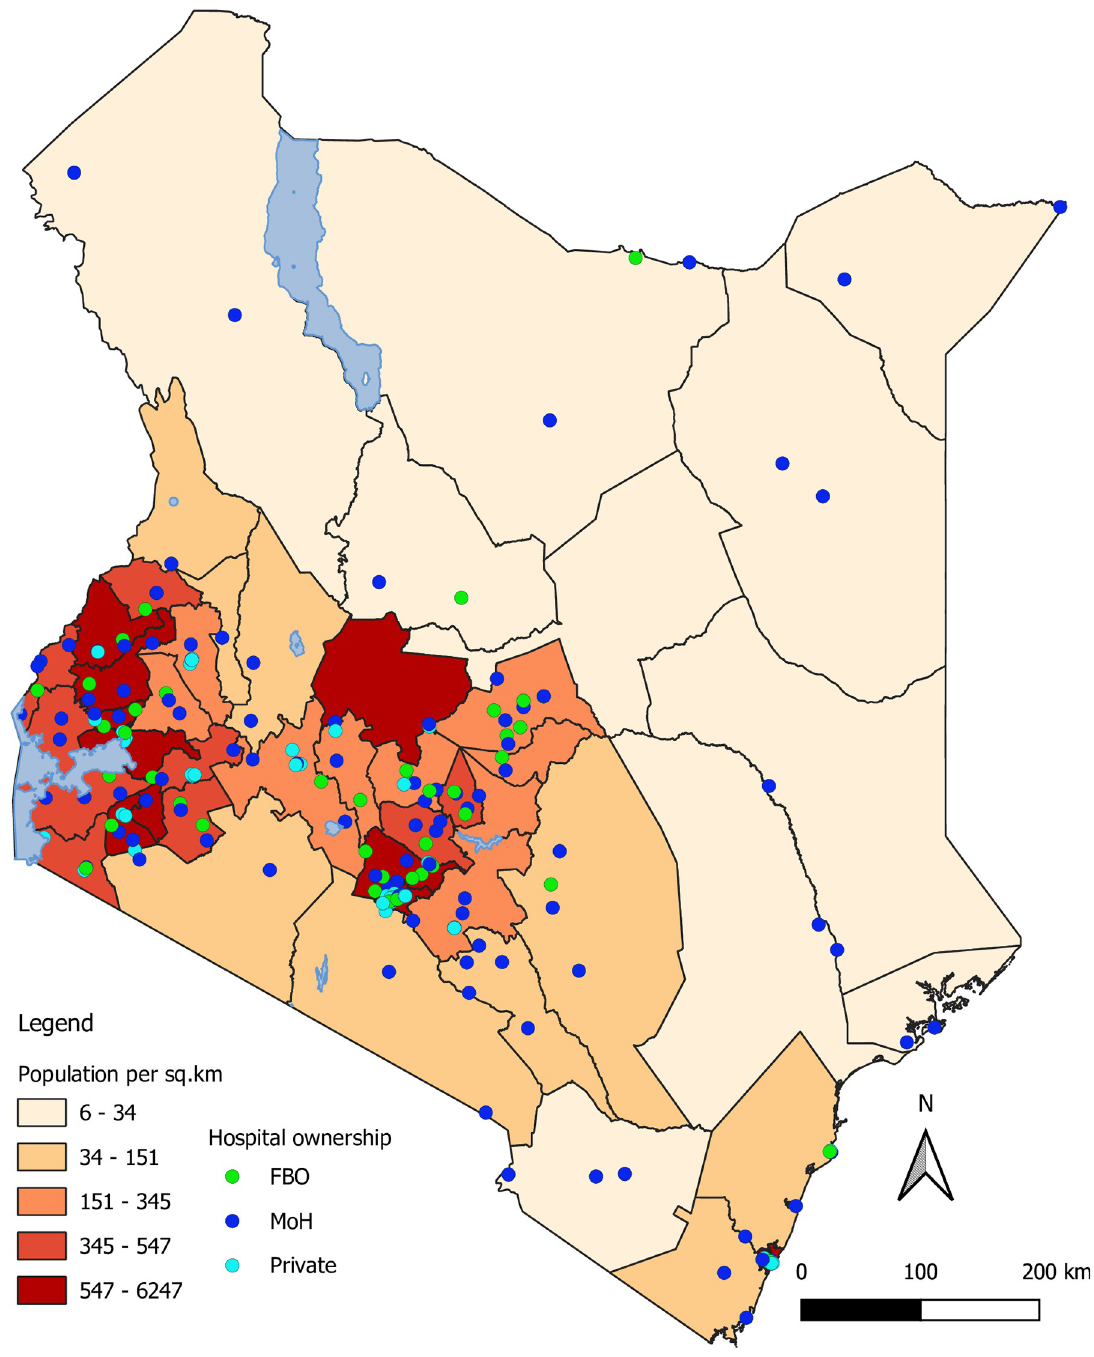
Fig 1. Distribution of the 204 hospitals across Kenya with the corresponding county population density based on 2019 census report in Kenya.